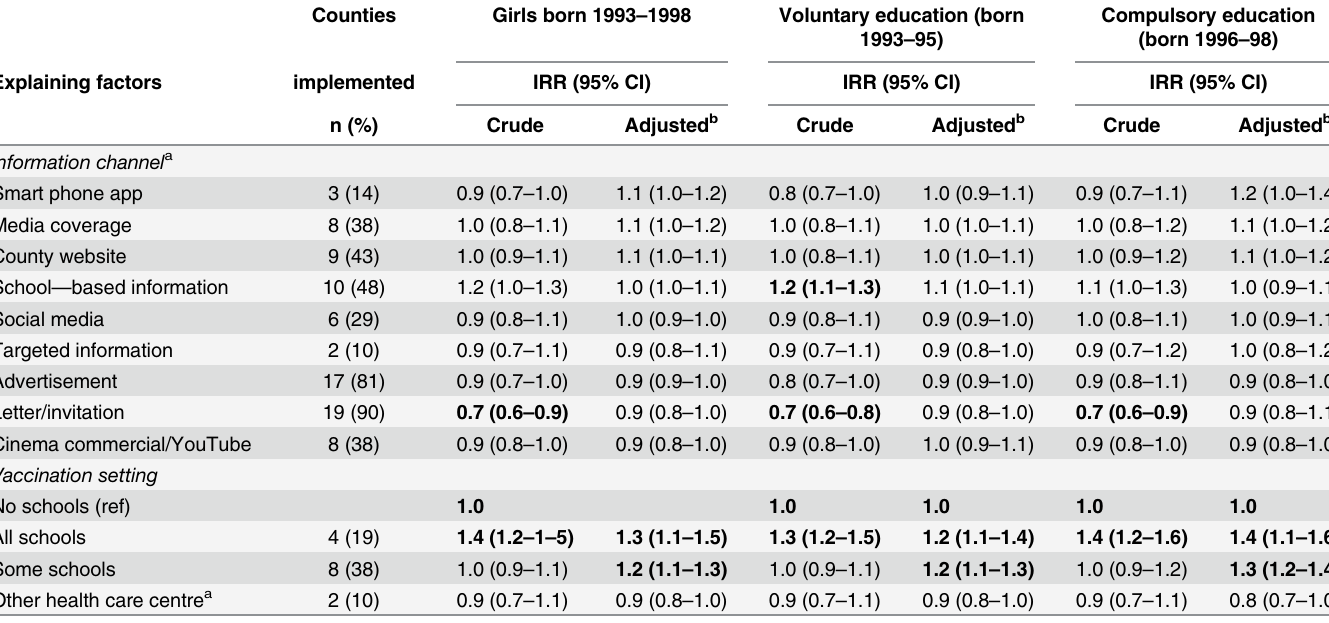
Table 2. Impact of implementation strategy on catch-up vaccine uptake among girls born 1993 – 98 and stratified by two age-groups, Sweden 2012 –